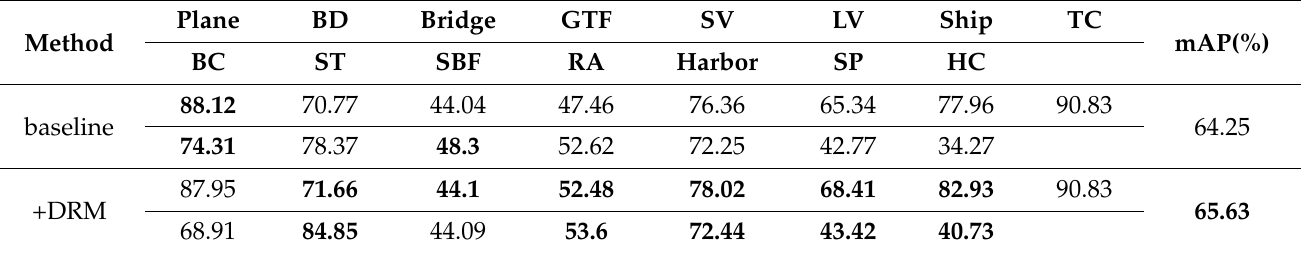
Table 1. Detection accuracy in the ablation study of using DRM or not with DOTA test dataset. The bold numbers denote the highest values in each class.